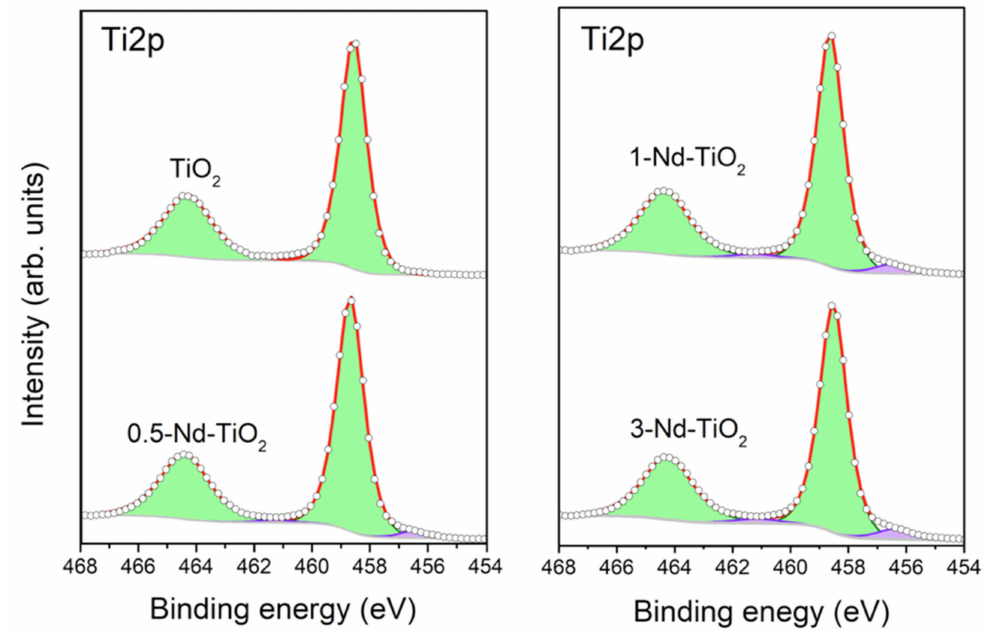
Figure 3. Curve-fitting XPS analysis of high-resolution Ti 2p spectrum from 0, 0.5, 1 and 3 wt.% Nd-doped TiO 2 . The green doublet is assigned to titanium with oxidation state Ti 4+ and the purple doublet to Ti 3+